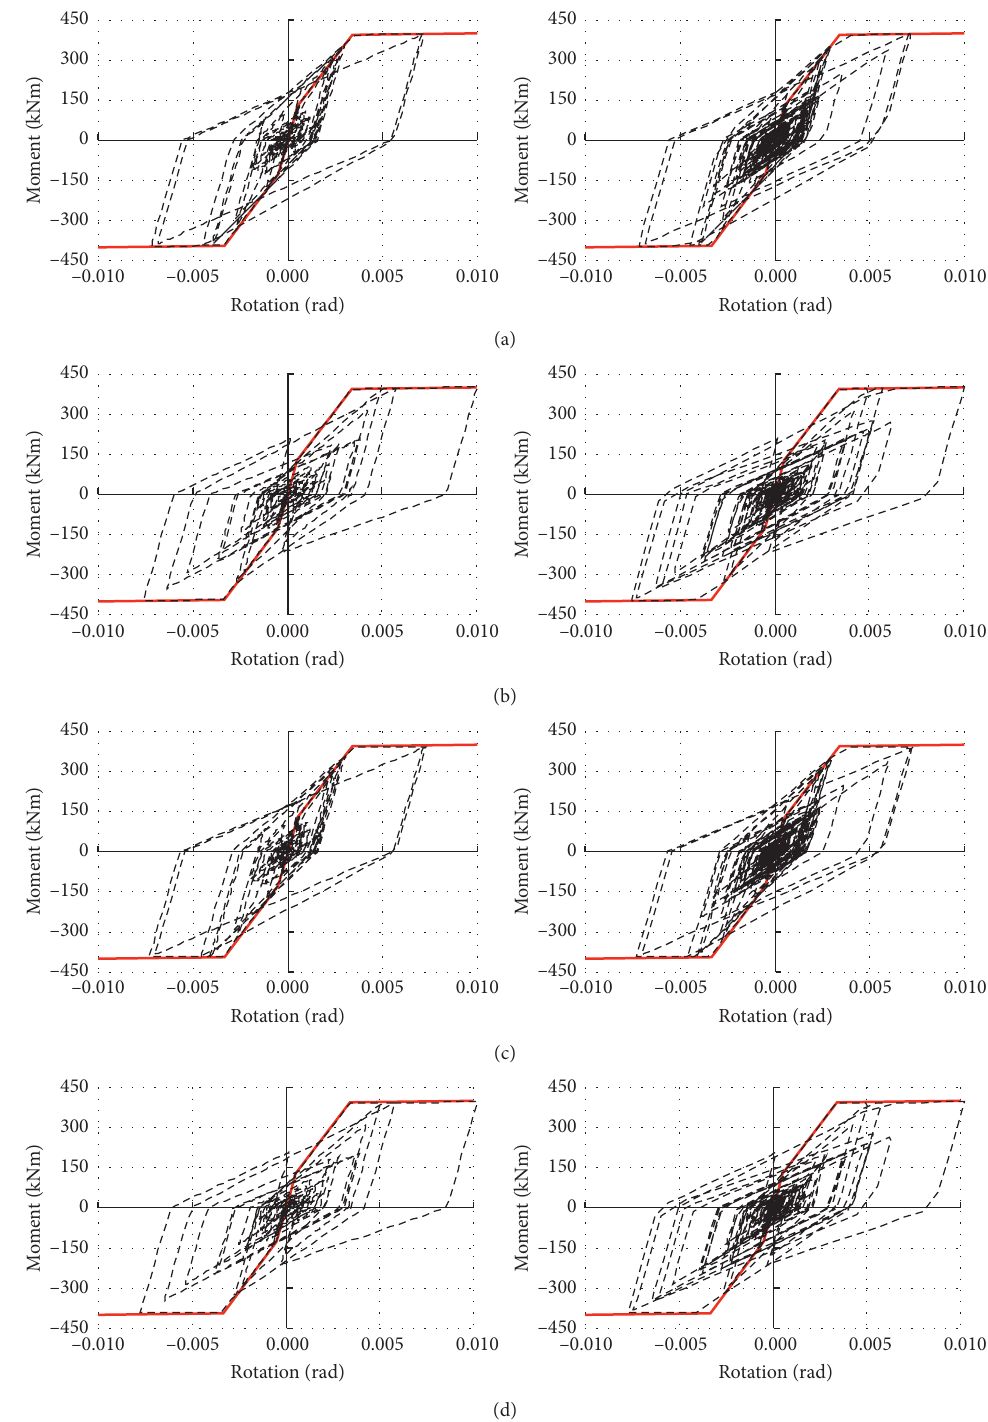
Figure 7: Examples of hysteretic behaviours of a plastic hinge under seismic sequences. (a) Original plastic hinge under mainshock (left) and seismic sequence 1 (right). (b) Original plastic hinge under mainshock (left) and seismic sequence 2 (right). (c) FRP retrofitted plastic hinge under mainshock (left) and seismic sequence 1 (right). (d) FRP retrofitted plastic hinge under mainshock (left) and seismic sequence 2 bottom ends of the first storey columns, while other plastic hinges experienced minor damage. The effect of aftershocks on FRP retrofitted frame is significant as can be seen in Figure 9(d). With light damage in the